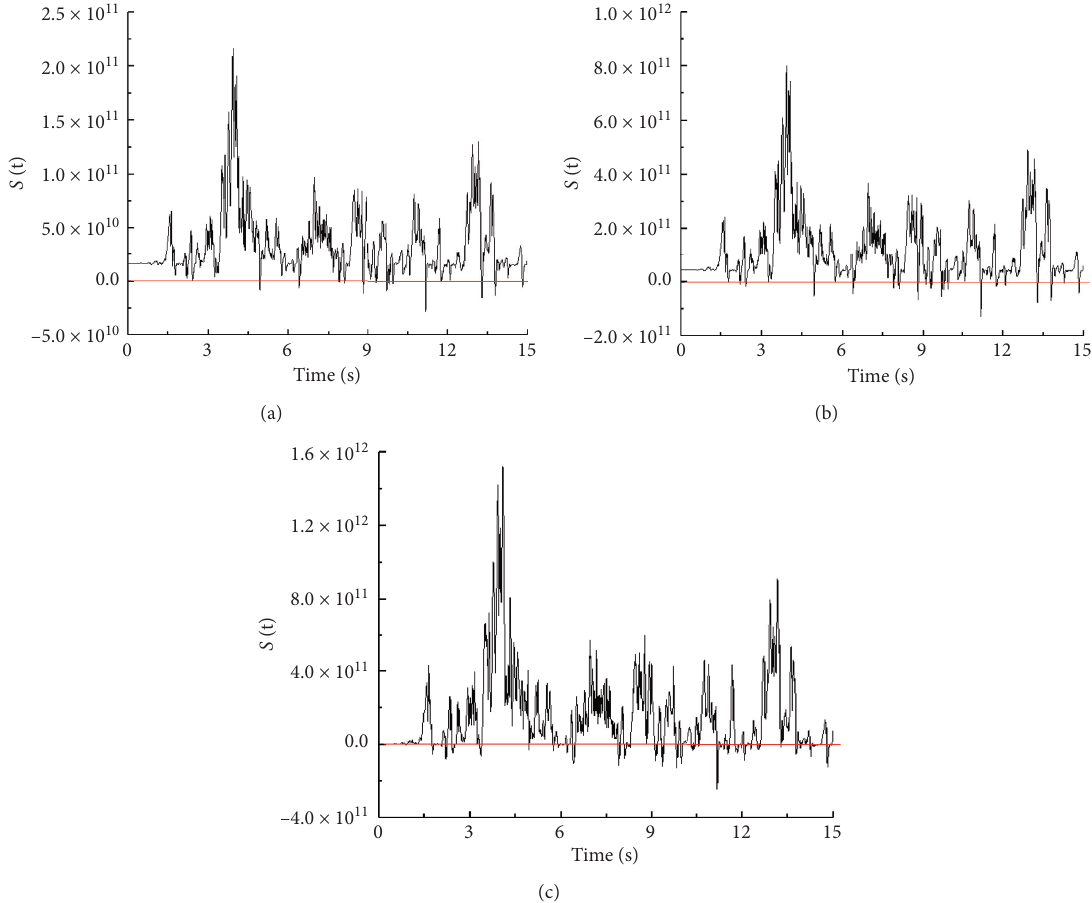
Figure 9: Dynamic stability equation curves with different PGAs (unit: J). (a) 0.15g; (b) 0.3g; (c)